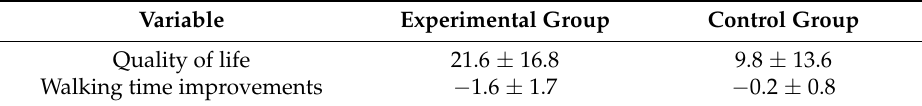
Table 3. Brief Summary of Key Findings reported by Lee et al.